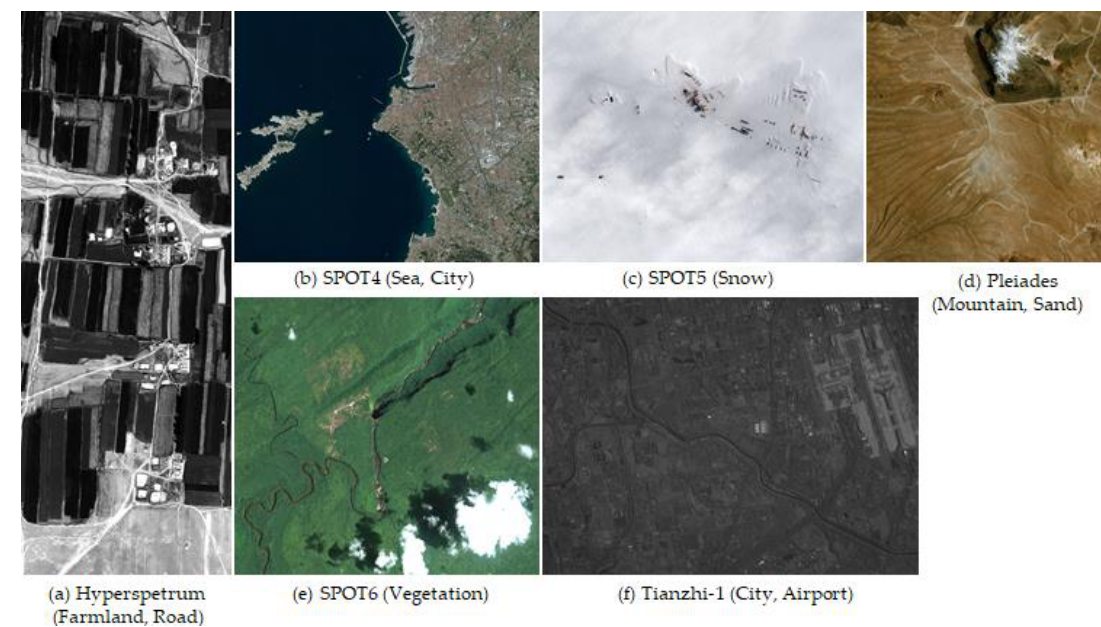
Figure 1. Remote sensing images with different landscapes used in the experiment.